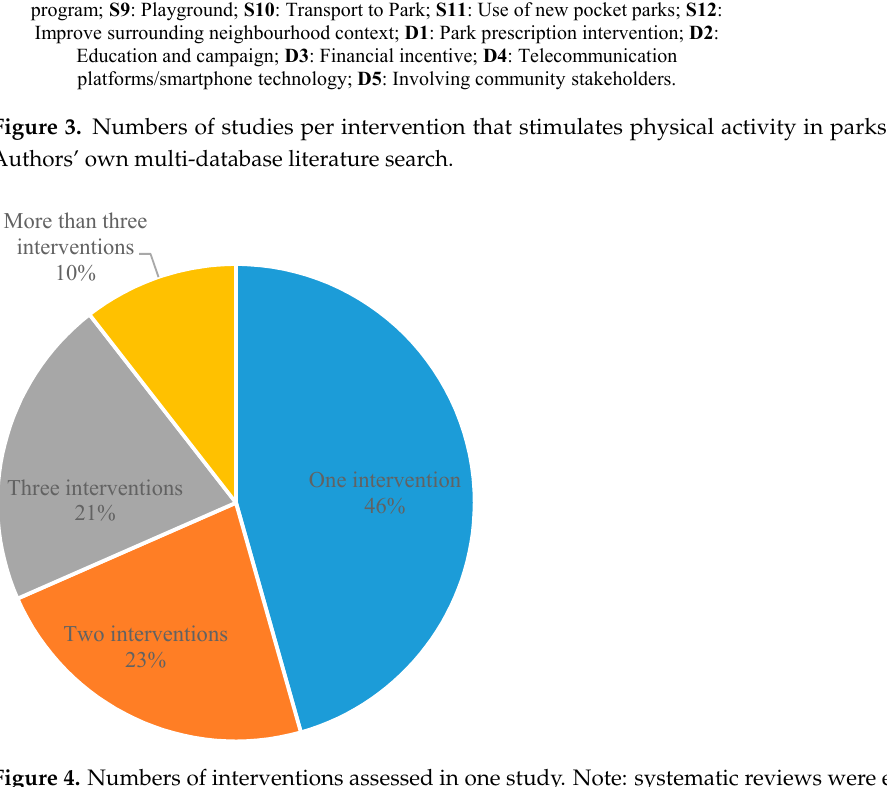
Figure 4. Numbers of interventions assessed in one study. Note: systematic reviews were excluded. Source: Authors’ own multi-database literature search.